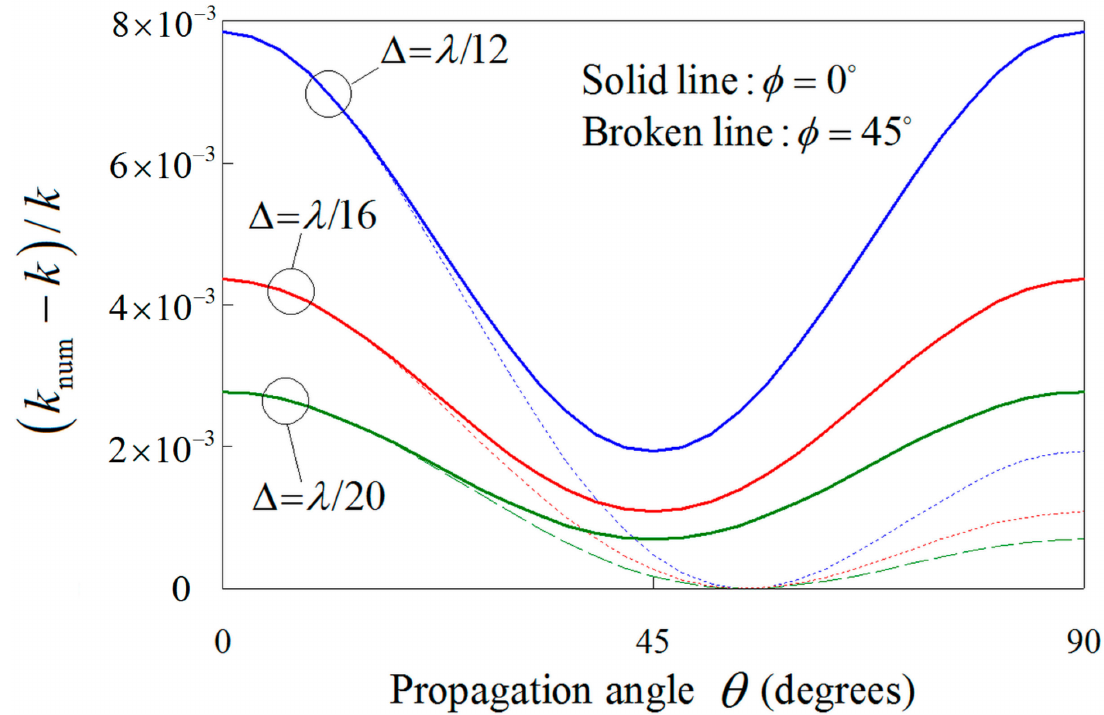
Figure 9. Propagation error of the numerical wavenumber, k num , for the FDTD method combined with the proposed PI model. Note that φ , θ are the angles of the spherical coordinate system ( r , φ , θ ) . Although the error of the PI model increases at φ = 45 ◦ , it remains approximately 10 − 3 times lower than that of the FDTD method for the same grid size ∆